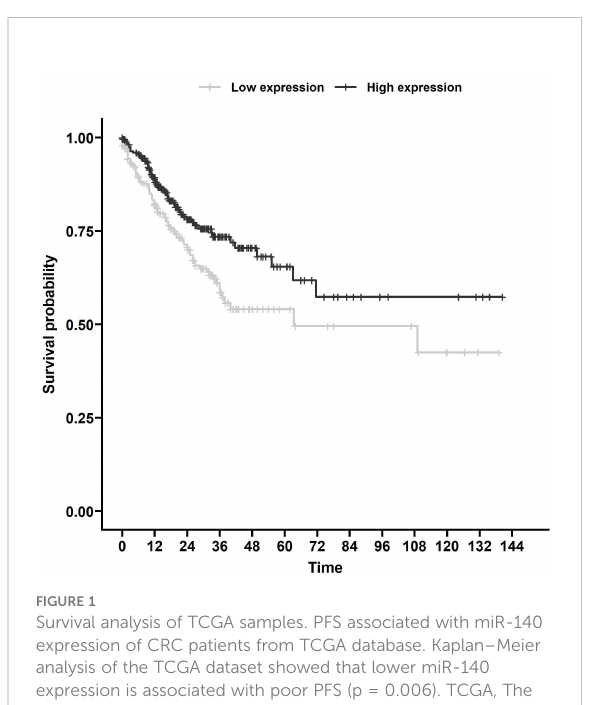
FIGURE 1 Survival analysis of TCGA samples. PFS associated with miR-140 expression of CRC patients from TCGA database. Kaplan – Meier analysis of the TCGA dataset showed that lower miR-140 expression is associated with poor PFS (p = 0.006). TCGA, The Cancer Genome Atlas; PFS, progression-free survival; CRC, colorectal